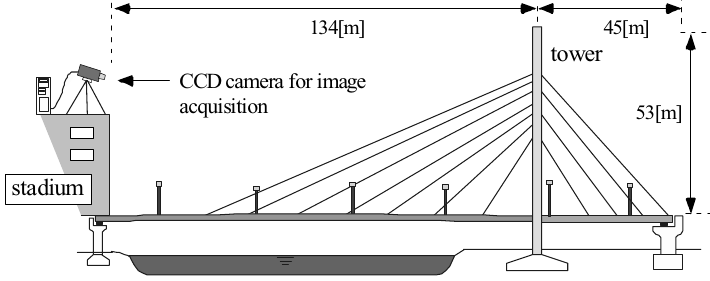
Fig. 2. Measurement of sequential images with a CCD camera in T-Park Bridge.